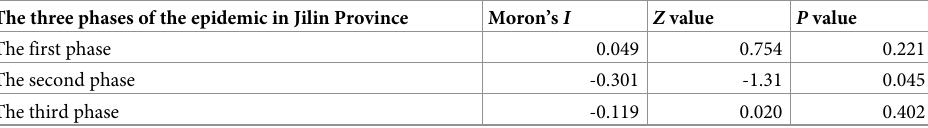
Table 5. Global autocorrelation of the incidence of three phases of COVID-19 outbreaks in Jilin Province. The three phases of the epidemic in Jilin Province